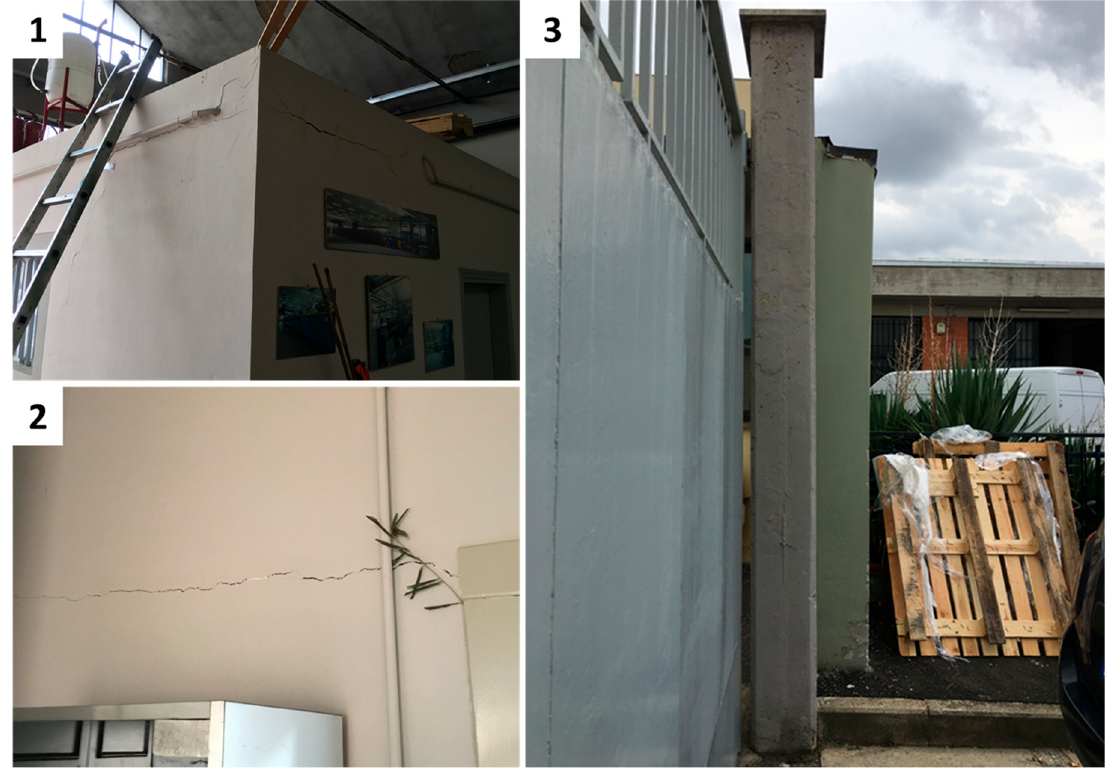
Figure 12. Cracks recognized during the field survey in Montemurlo. Subsidence-induced damage recognizable in the internal (Photo 1 and 2) structures of a textile shed. The same structure records a small tilting of few degrees (see the concrete column with respect to the green wall of the shed—Photo 3).